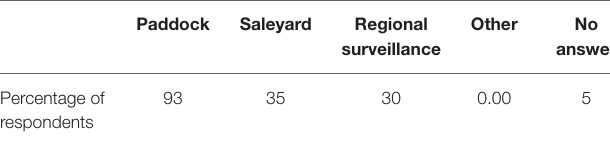
Where do you think new diagnostic services would be best